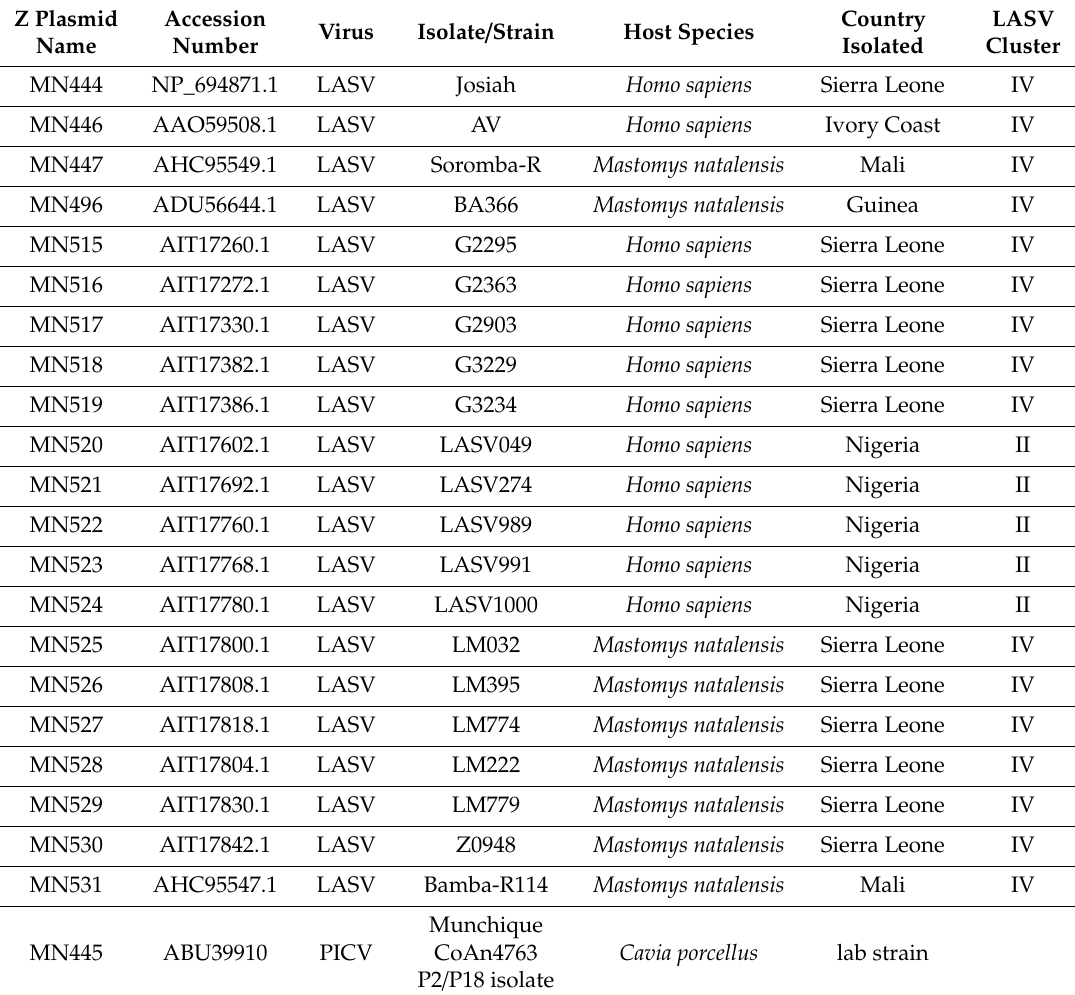
Table 1. List of the Z protein sequences and their expression plasmids used in this